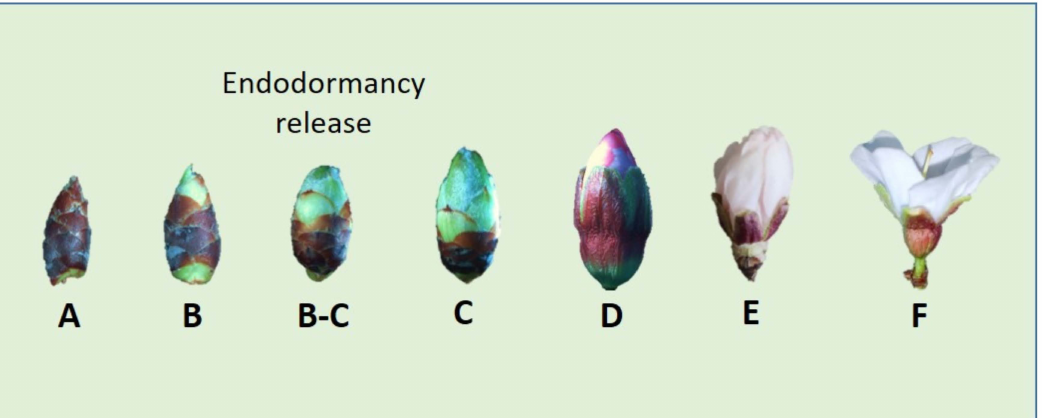
Figure 1. Almond phenological states from total endodormant flower bud to open flower. A is a totally endodormant flower bud, B is a swollen flower bud prior to endodormancy release, B-C is considered the endodormancy release state, C is a swollen bud after endodormancy release where sepals are clearly visible, D is a flower when only petals are visible, E is a flower with visible stamens and F is a completely open